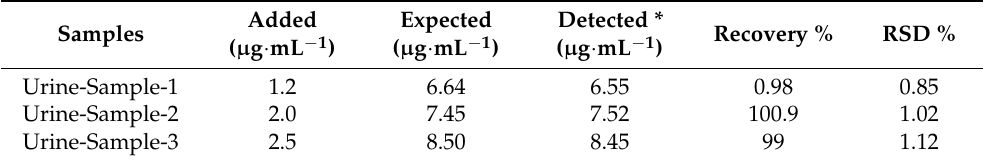
Table 2. Analytical reliability data for MMA detection from human urine samples using an MX-Ni composite-based electrochemical